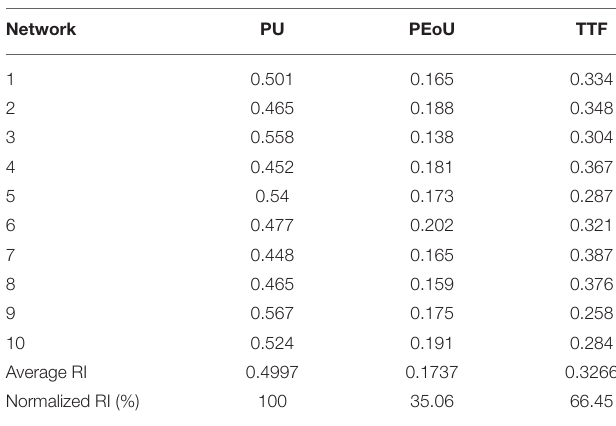
TABLE 10 | Sensitivity